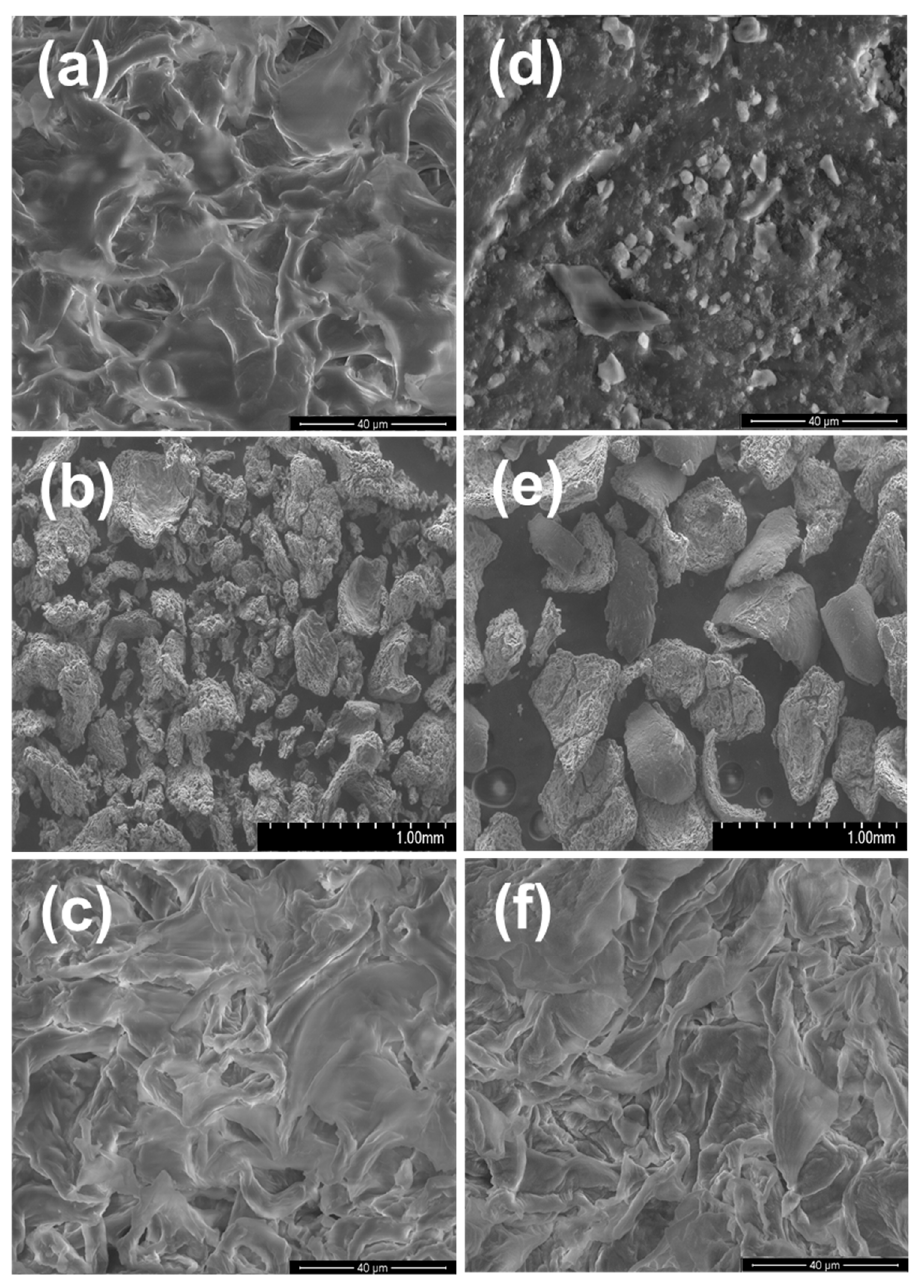
Figure 2. SEM micrographs of ( a ) OP 40 μ m, ( b ) BOP-Zr 1000 μ m, ( c ) BOP-Zr 40 μ m, ( d ) AP 40 μ m, ( e ) BAP-Zr 1000 μ m, and ( f ) BAP-Zr 40 μ m. ( e ) BAP-Zr 1000 µ m, and ( f ) BAP-Zr 40 µ